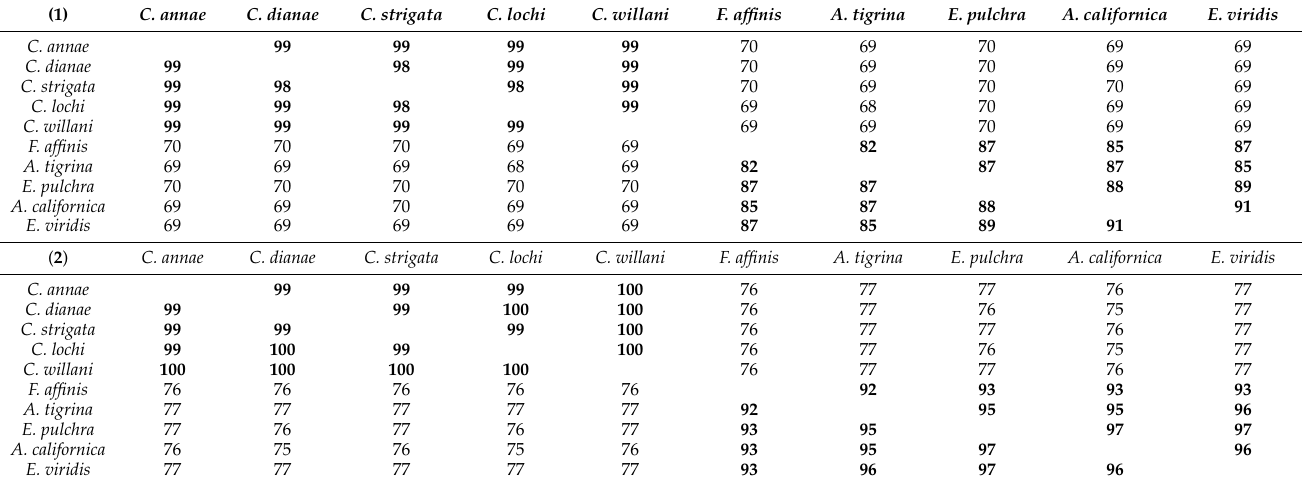
Figure 7. Multiple consensus amino acid sequence alignments of the latrunculin-binding region of heterobranch actins. Threonine T186 and arginine R210, directly interacting with latrunculins, are framed with yellow rectangles. Aspartic acid D187 and arginine R206 forming a salt bridge (indicated by arrows) are highlighted in green. The substitutions D187G and R206T are highlighted in blue. Highly conserved amino acids are marked with an asterisk. Table 3. Percent identity matrices of heterobranch actin sequences. ( 1 ) Identity matrix based on 808 nucleotide positions. ( 2 ) Identity matrix based on 269 amino acid positions. Values > 80% are shown in bold.